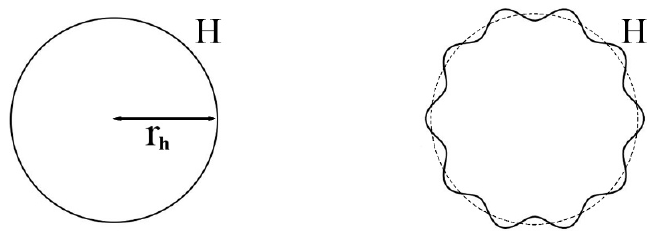
Figure 1 : BTZ horizon without (left) and with (right) soft hair